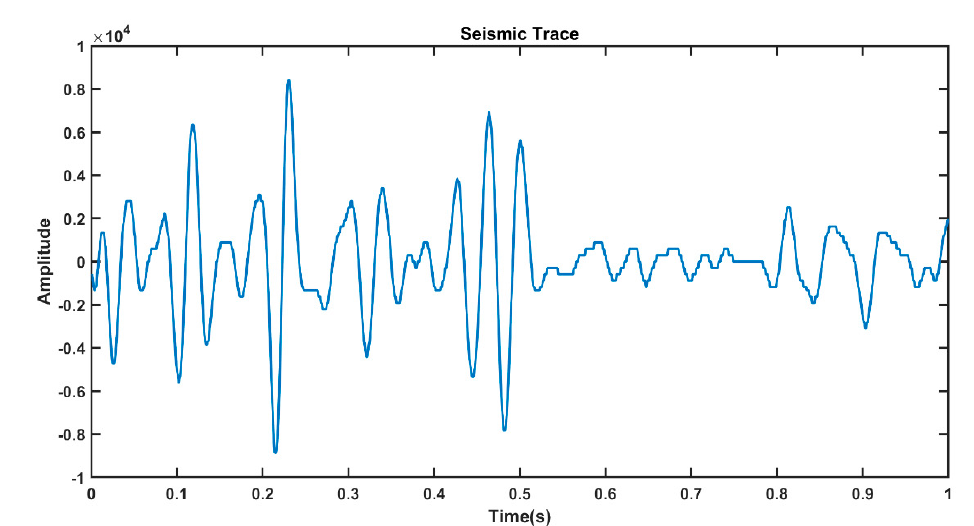
Figure 4. The seismic trace signal.